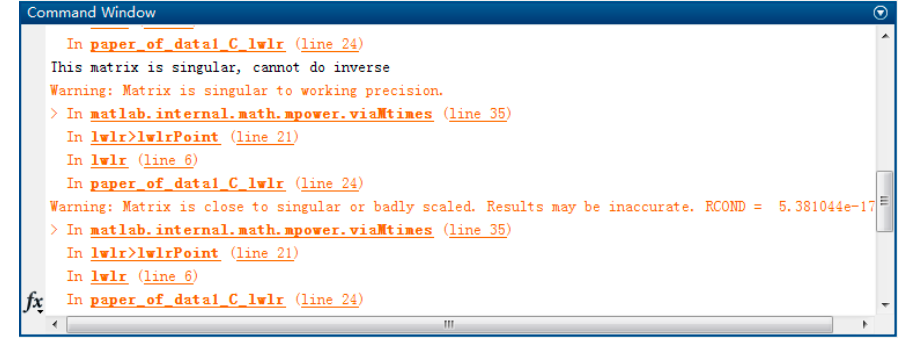
Figure 7. Matrix singular warnings during prediction using LWLR.